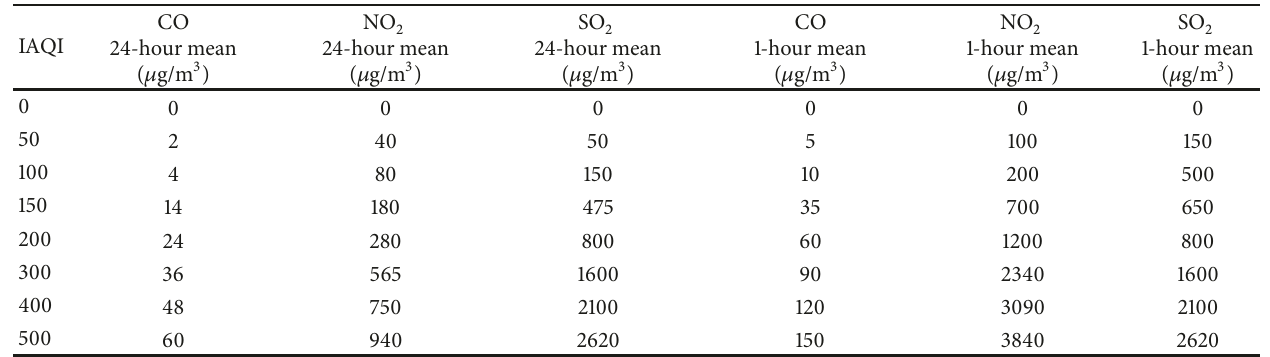
Table 2: IAQI breakpoints of different air pollutants.